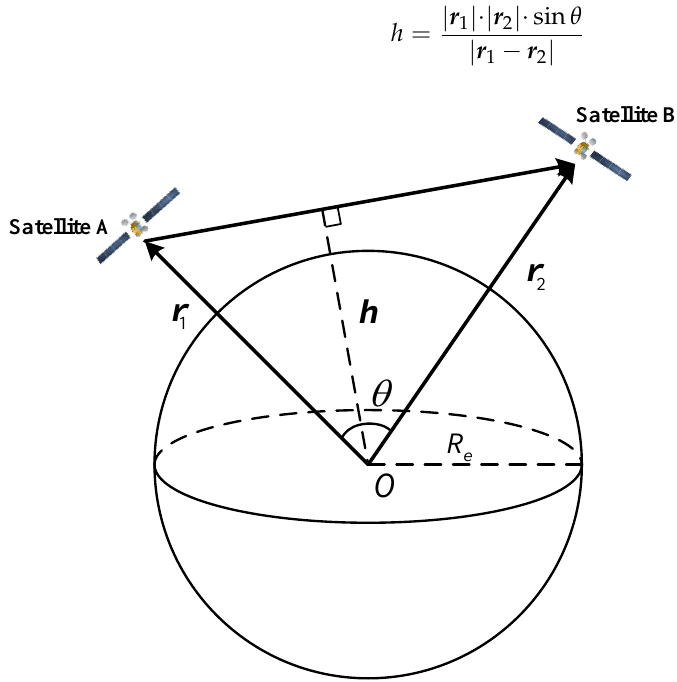
Figure 4. The visibility geometry of any two satellites in space.